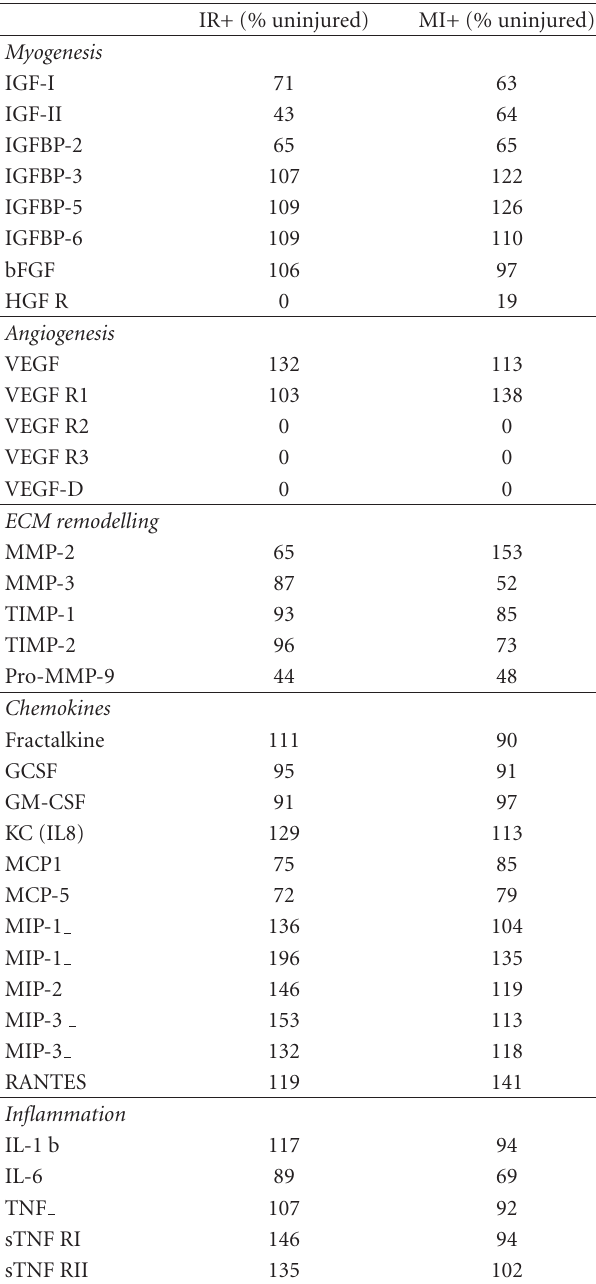
Table 1: Cytokine expressed in the ischemic-reperfused and myotoxin-treated muscles at day